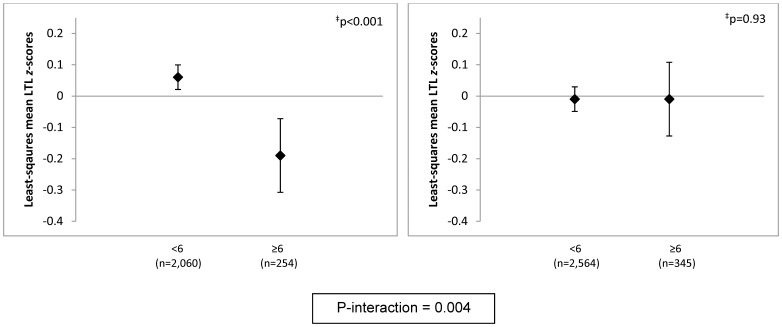
Adjusted* least-squares mean telomere length z-scores, by phobic anxiety level, stratified by smoking status (never or current/past).*, Models were adjusted for age in years (continuous), paternal age-at-birth (15–24, 25–29, 30–34, 35–39, ≥40 years), body mass index (continuous, kg/m2) and physical activity (continuous, MET-hrs/wk). Least squares means and 95% confidence intervals are shown. N = 20 excluded due to missing smoking status. ‡, P-value for test of difference in least-squares means.